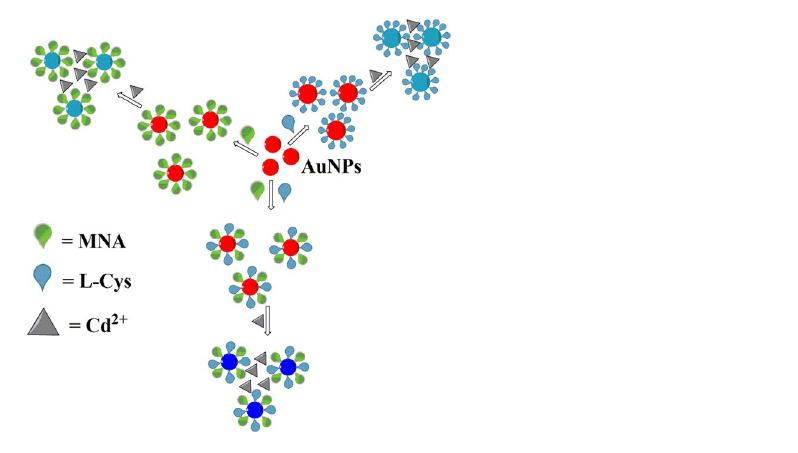
Figure 3. The proposed mechanism of Cd 2+ detection by different functionalized